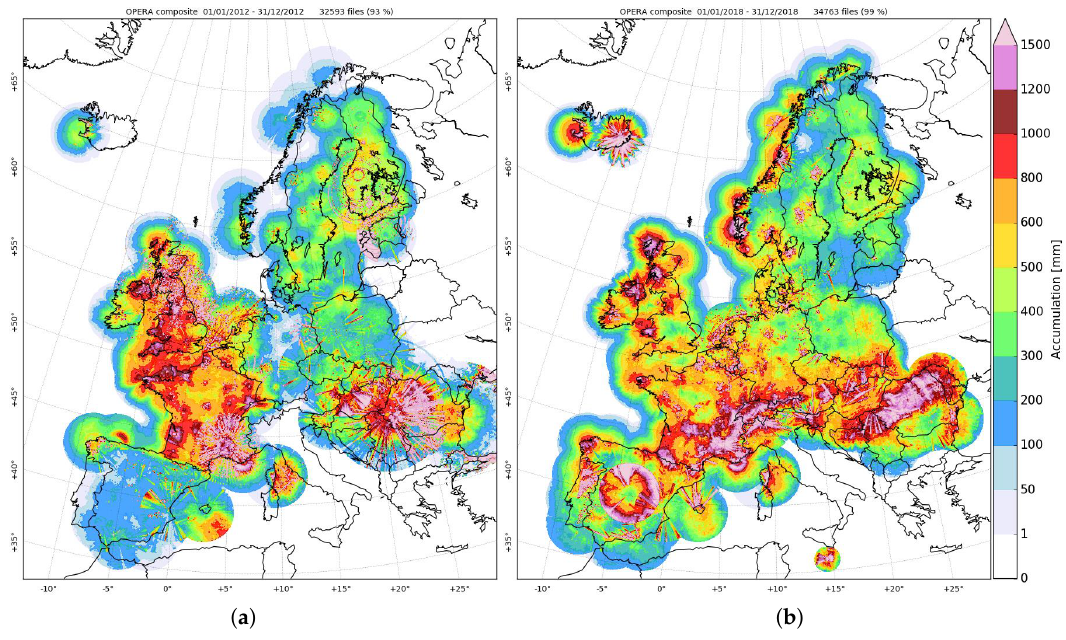
Figure 3. Annual precipitation in ( a ) 2012 and ( b ) 2018.